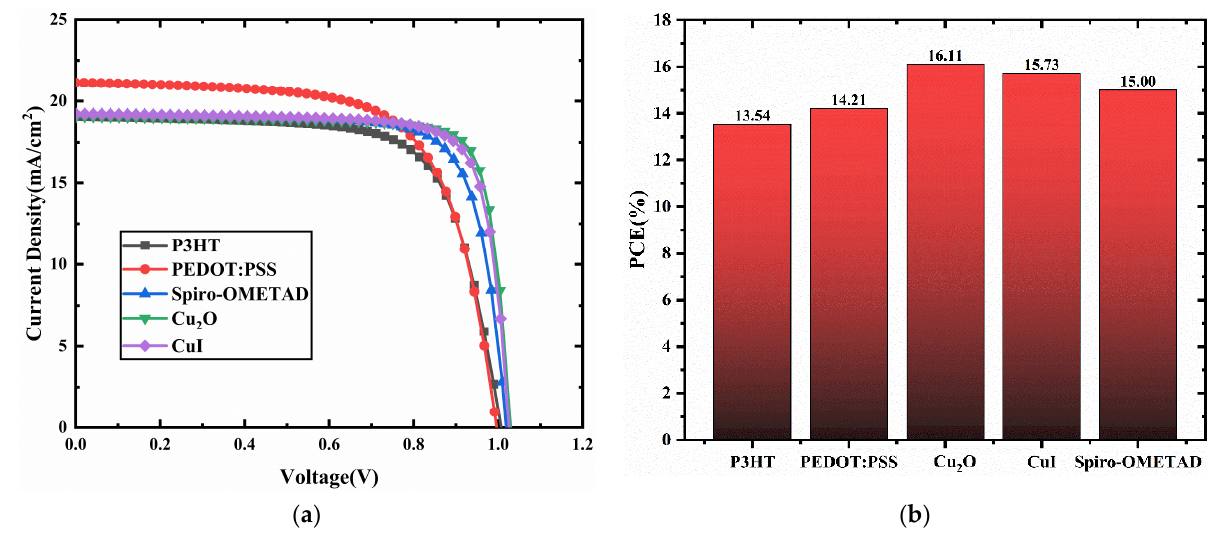
Figure 2. ( a ) Comparison of J-V characteristic curves for different HTMs as HTL; ( b ) PCE for different HTMs as HTL. Table 4. Performance parameters of different HTMs as HTL.